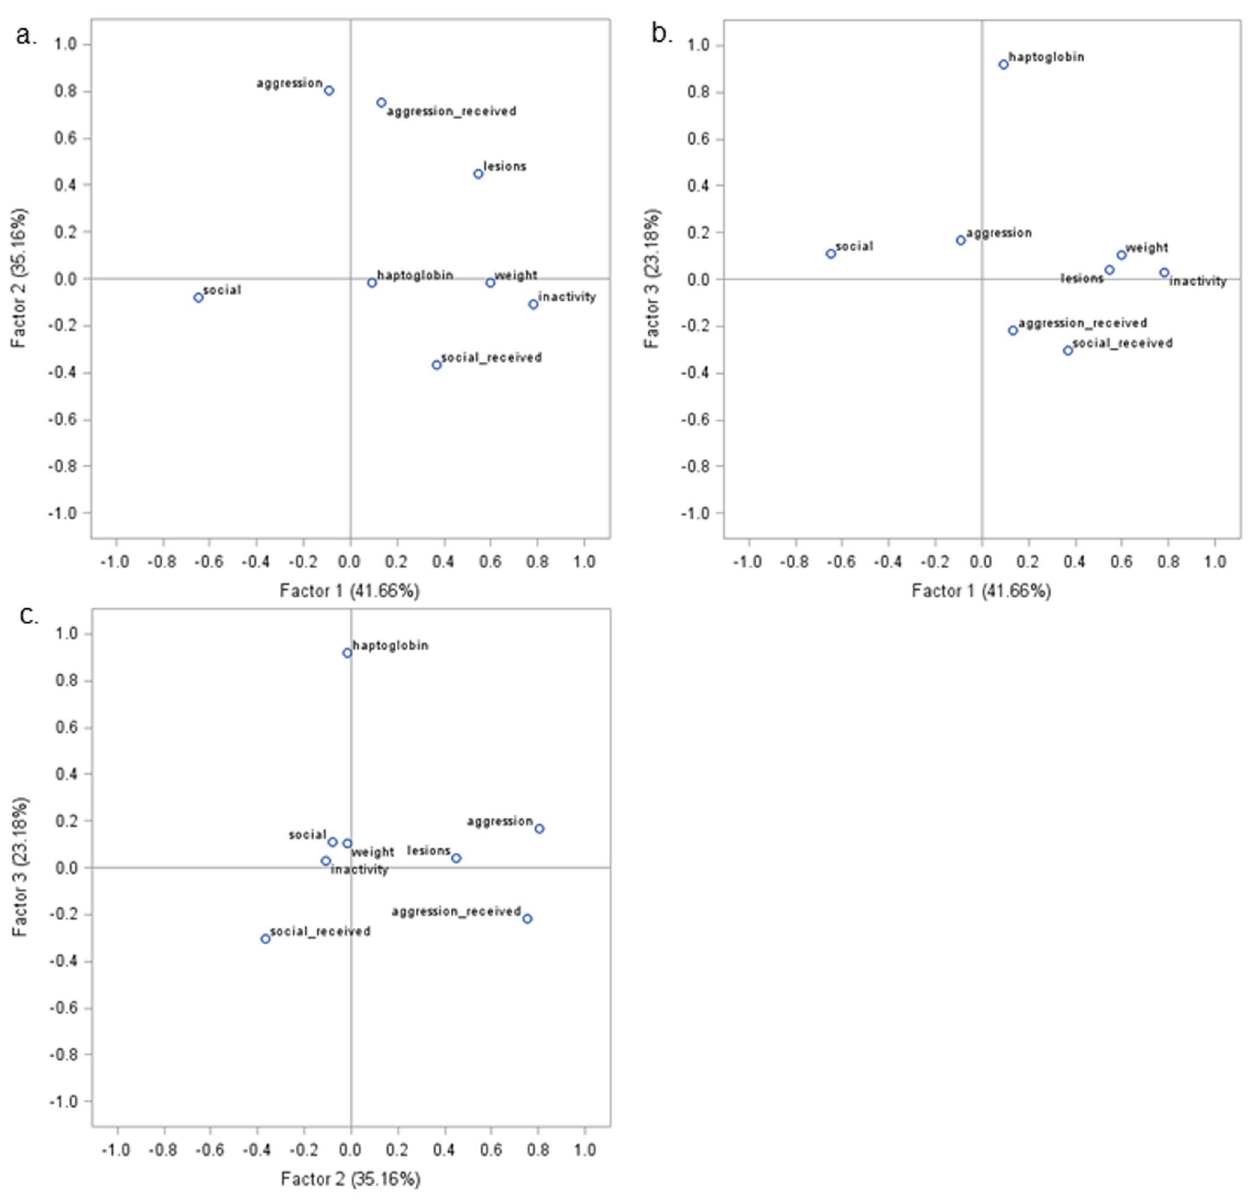
Figure 1. Factor maps of the PCA. Distributions in relation to the principal component factor 1 and 2 (A), factor 1 and 3 (B), and factor 2 and 3 (C) extracted after principal component analyses (PCA). Loadings of each variable on the principal component serve as coordinates on the X-axis and Y-axis,